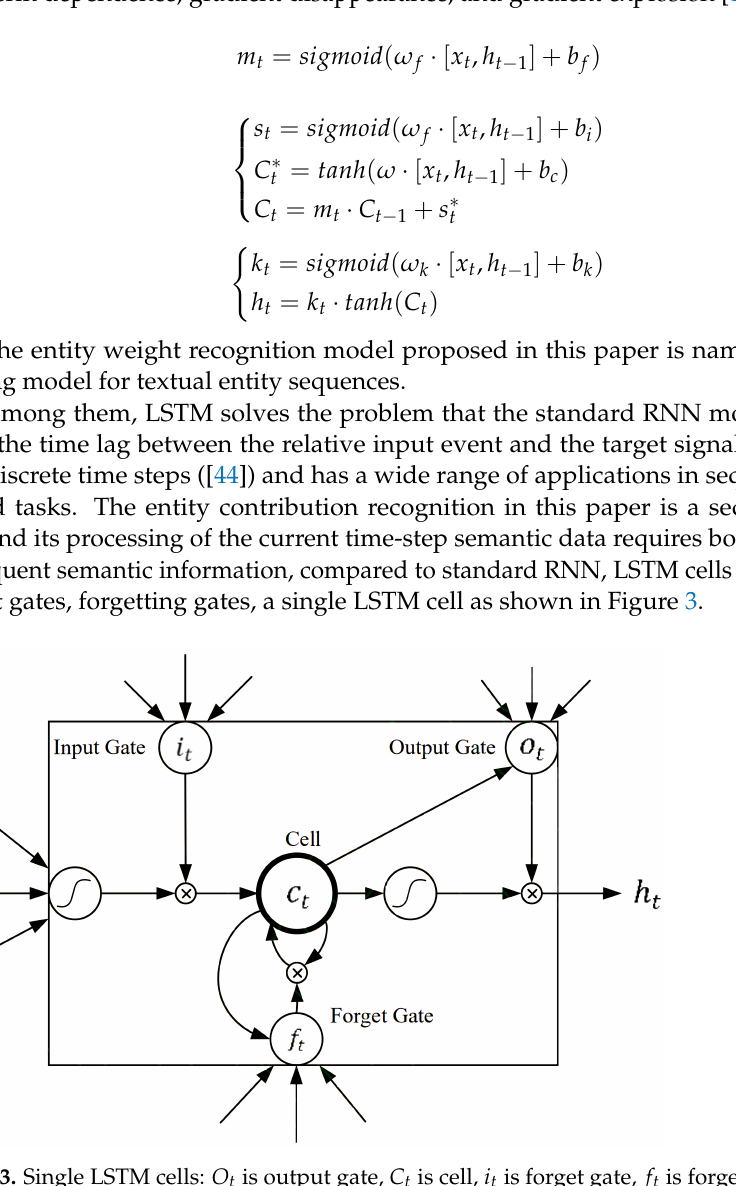
Figure 3. Single LSTM cells: O t is output gate, C t is cell, i t is forget gate, f t is forget